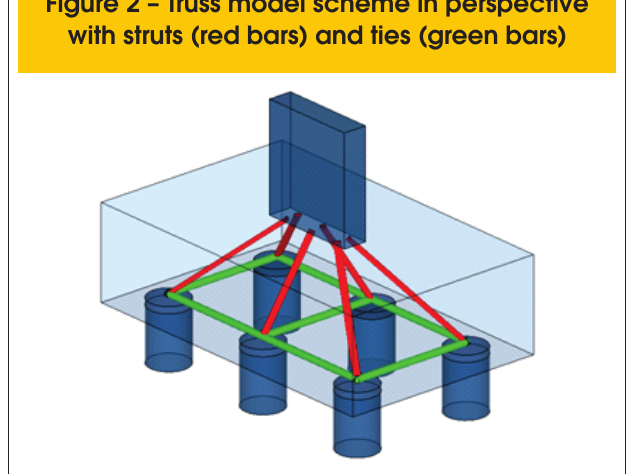
Figure 2 – Truss model scheme in perspective with struts (red bars) and ties (green bars)